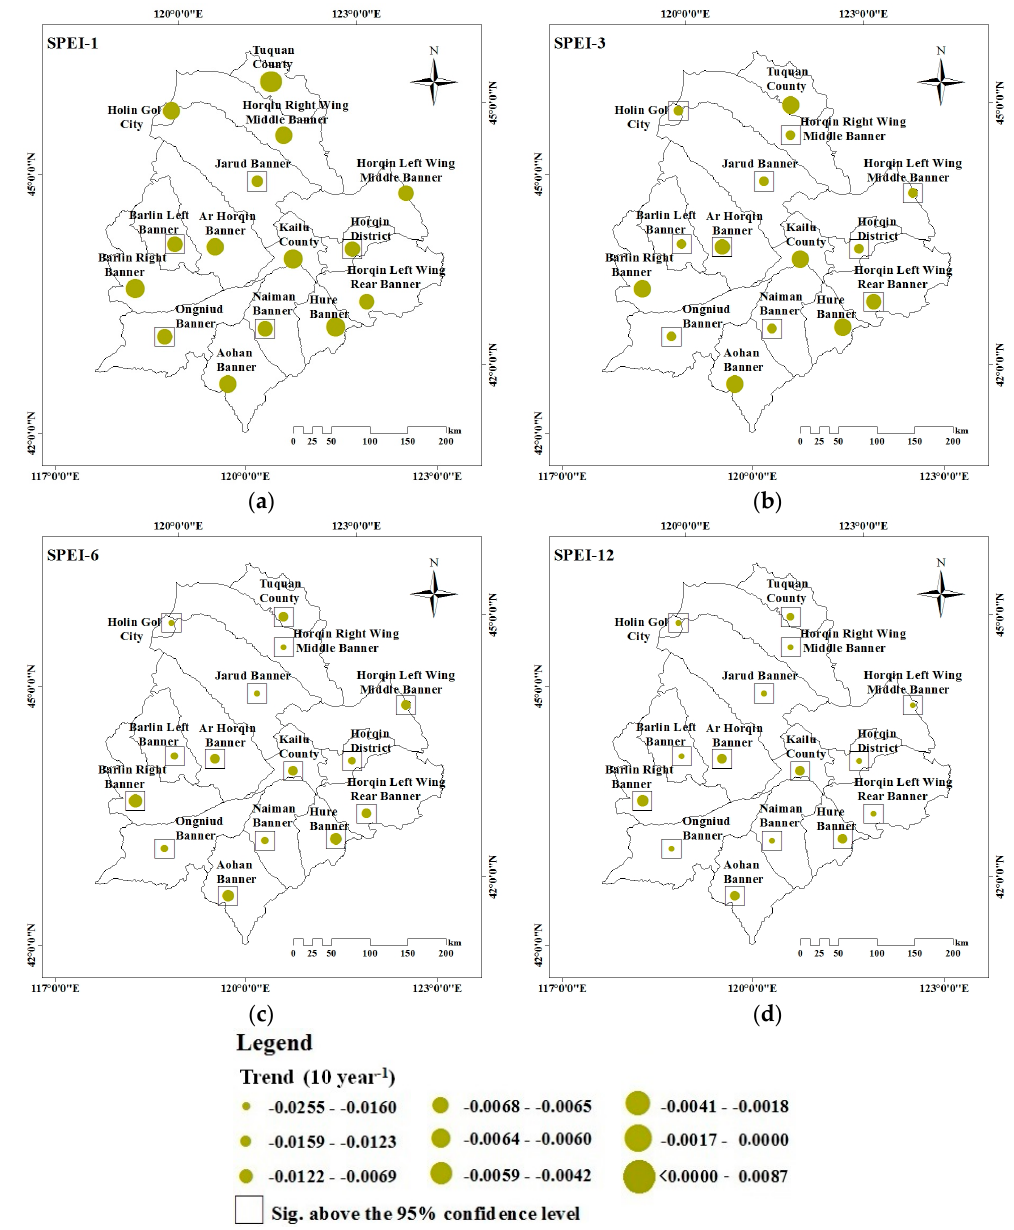
Figure 5. Spatial patterns of trends per decade for SPEI-1 ( a ); SPEI-3 ( b ); SPEI-6 ( c ); and SPEI-12 ( d ) in Horqin Sandy Land during 1964–2013.